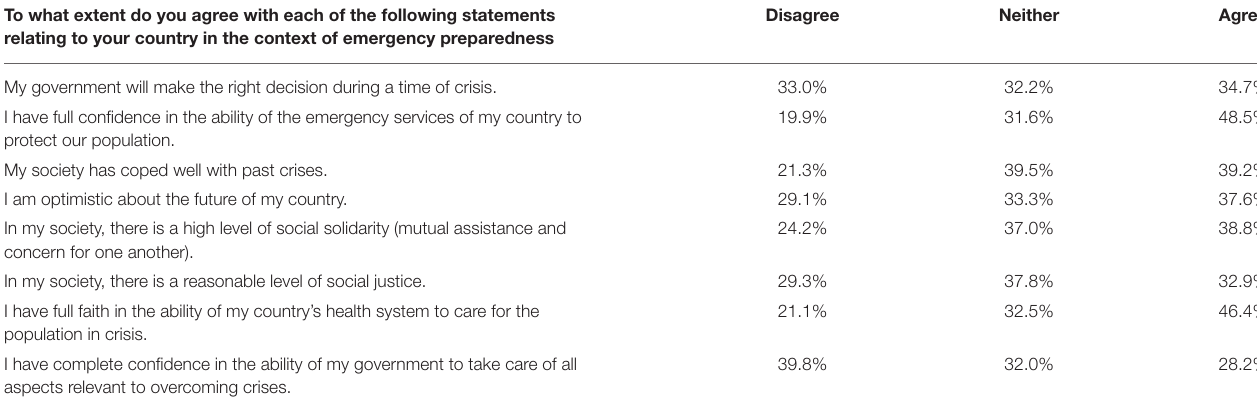
Disagree Neither Agree